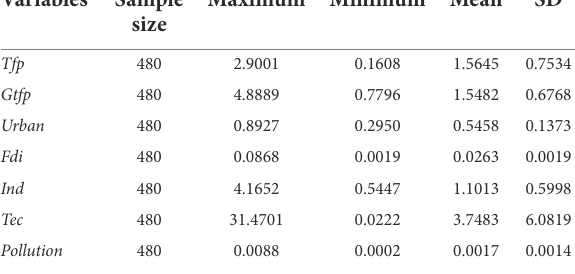
TABLE 1 Descriptive statistics for